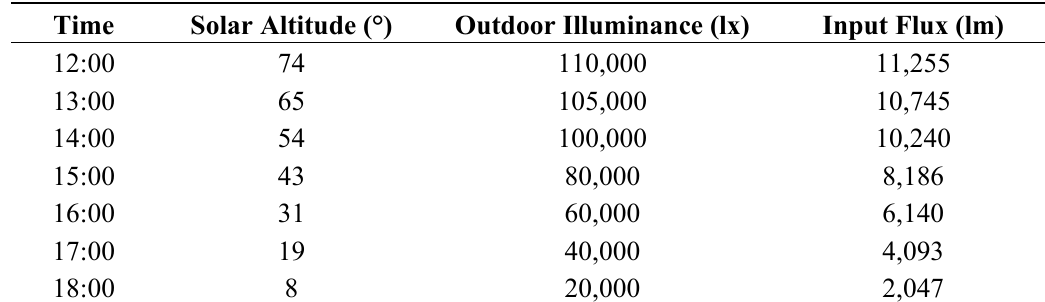
Table 2. Average illuminance at different times of the day and the calculated flux for the concentrator.